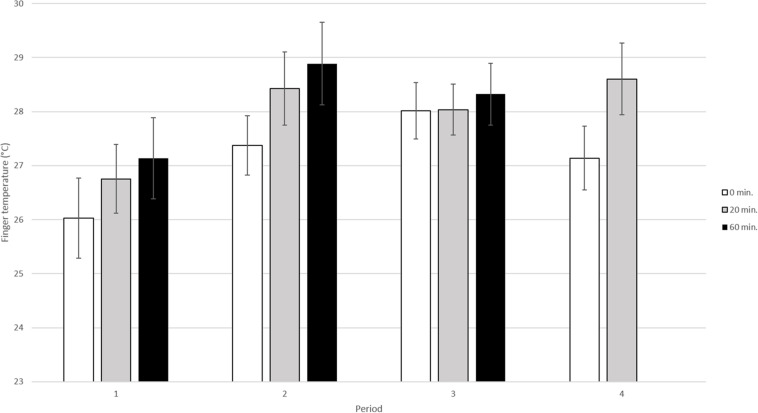
Mean fingertip temperature in °C (±SE) in the elderly obtained during the four different periods. The dog and its handler were present during period 2 and 3 but not during period 1 and 4. During each visit fingertip temperature was recorded three times; at 0 min, i.e., before the dog entered, at 20 min, when the dog was present and at 60 min, i.e., when the dog had left (n = 13 elderly sampled four times per period).